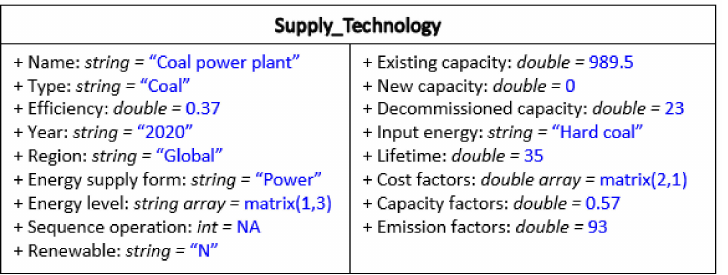
Figure 9. An example of a supply technology object, showing the assigned attributes.